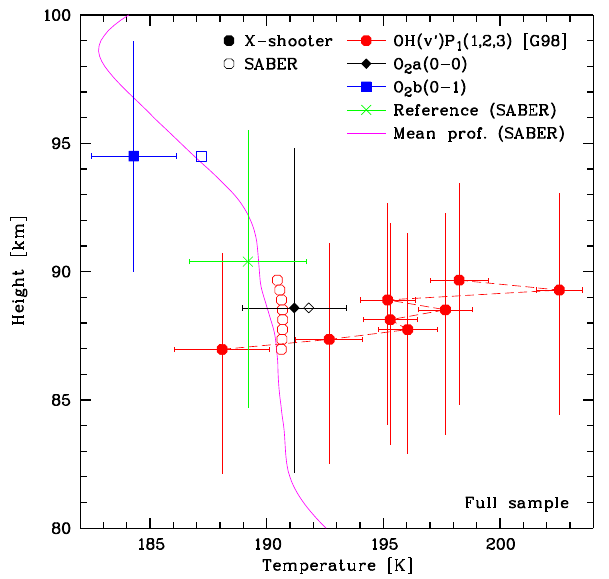
Figure 12. Comparison of temperatures in K and the corresponding heights in km for the full X-shooter sample. Solid symbols show X-shooter T rot measurements and their uncertainties (excluding er- rors related to the molecular parameters where HITRAN was used) for OH from v (cid:48) = 2 to 9 (cf. Fig. 11) using the first three P 1 lines (circles), O 2 a (0-0) (diamond), and O 2 b (0-1) (square). The effective emission heights were derived by means of SABER data. The bars in height direction mark the profile width at half maximum. The cross is related to the SABER T kin for the O 2 a (0-0)-based reference profile. Open symbols indicate the T kin results for the emission pro- files of the bands measured by X-shooter. For these data, we assume temperature uncertainties of 2.5K. The solid curve shows the mean T kin profile for the X-shooter sample.